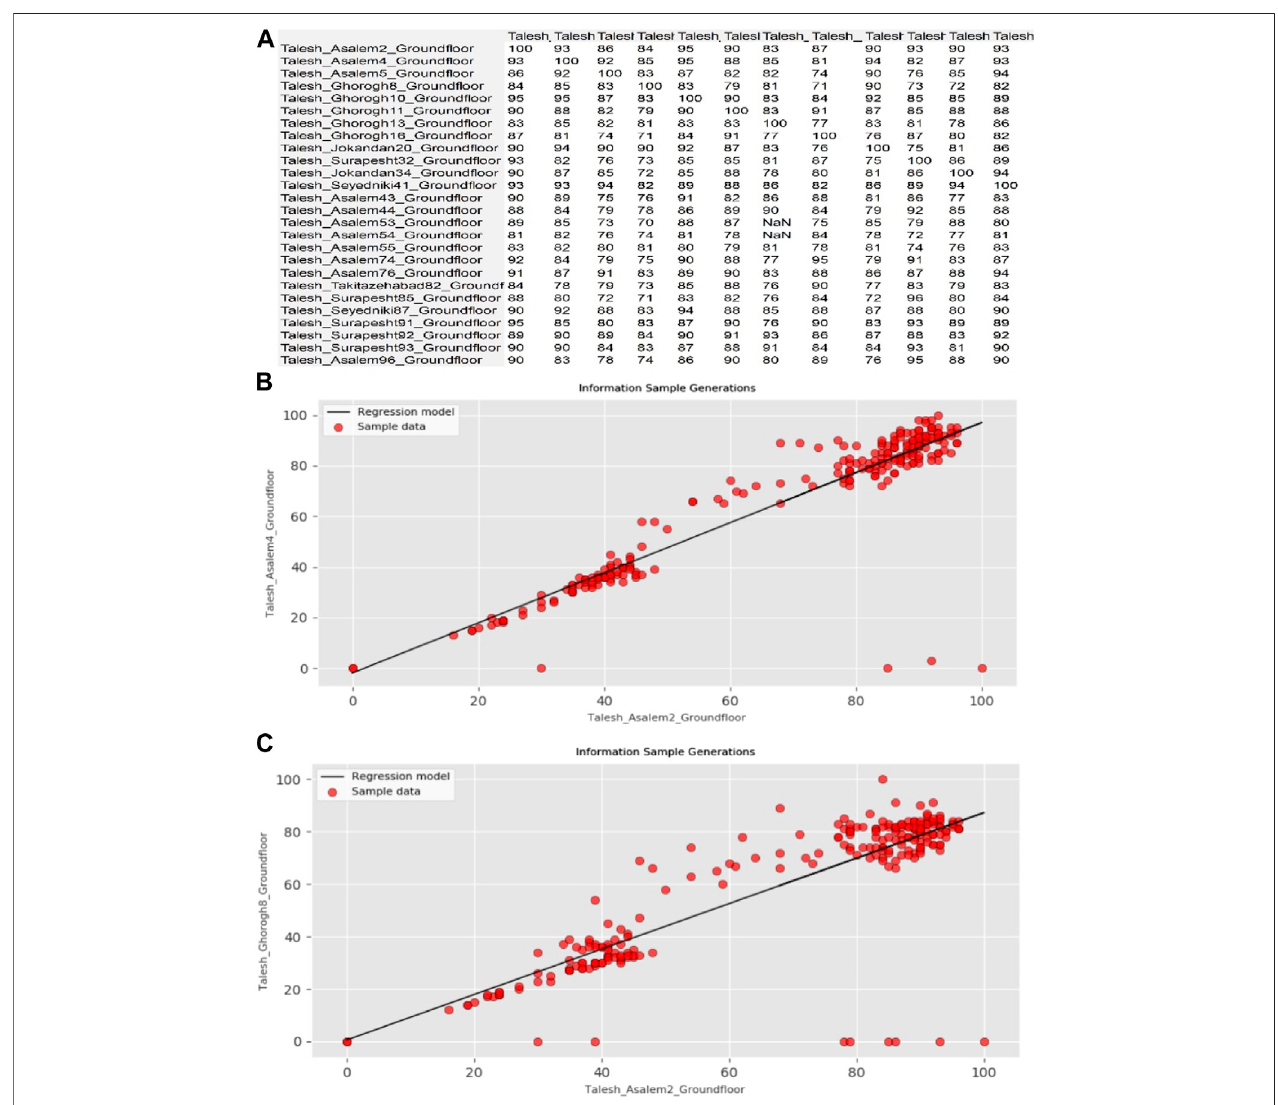
FIGURE 8 | (A) Part of the percentage similarity matrix of plans (B,C) Illustrating the percentage of similarity of 48 plans with each other Source: Author.